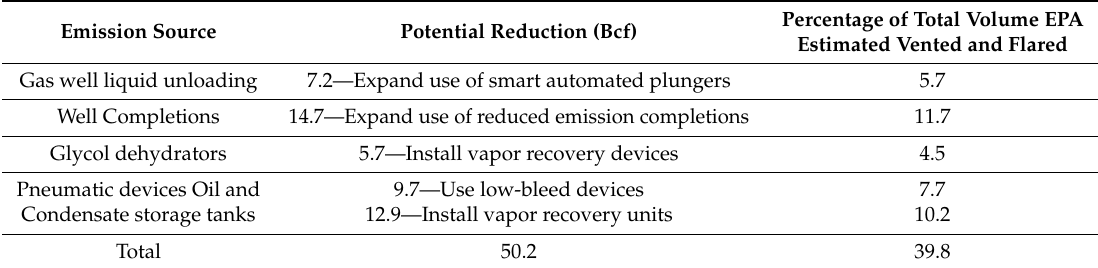
Table 8. Potential nationwide reductions on onshore federal leases from increased use of venting and flaring reduction technologies